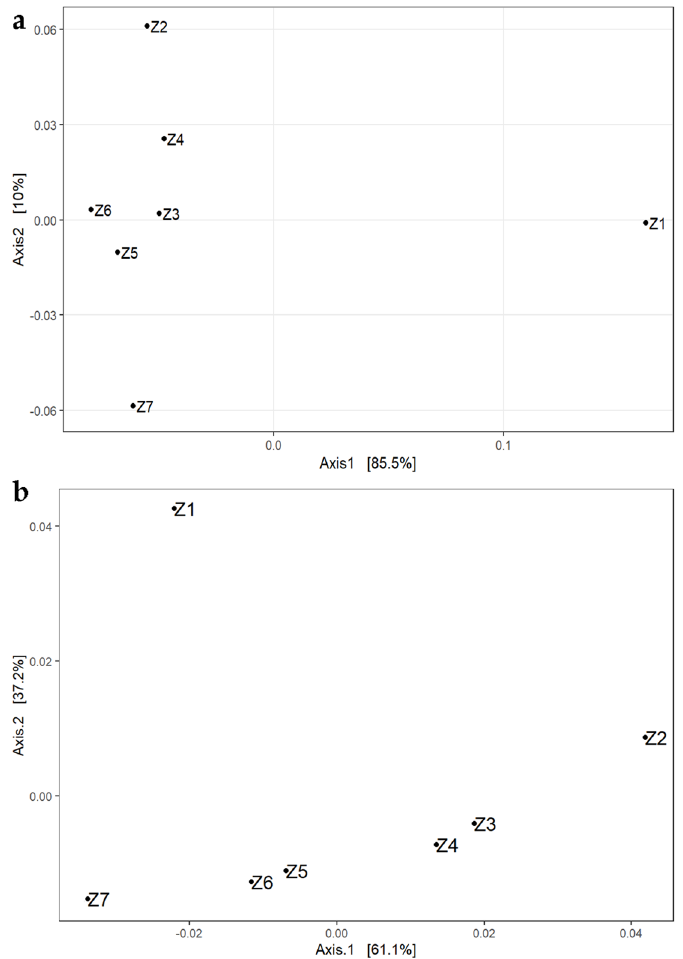
Figure 1. The DPCoA ( a ) and MDS ( b ) plots at the OTU level showing the variability between samples. Intestine (sample Z1); days of ripening: 0 (sample Z2), 2nd (sample Z3), 7th (sample Z4), 10th (sample Z5), 14th (sample Z6), and 21st (sample Z7).